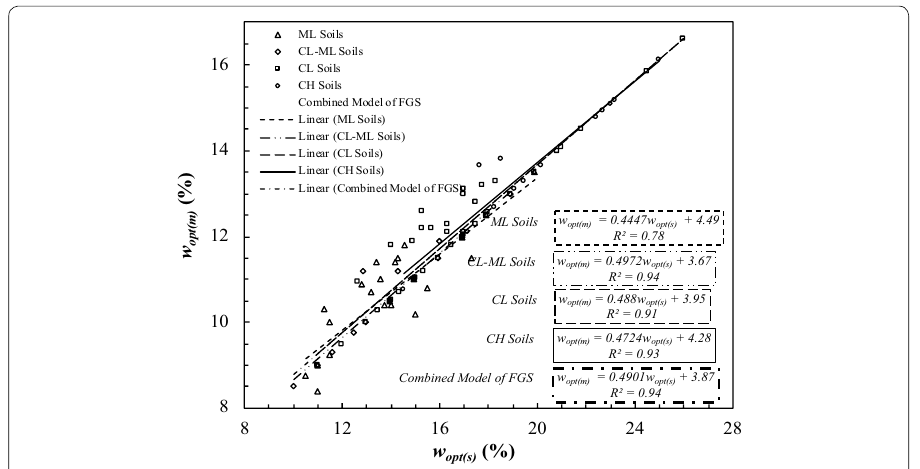
Fig. 9 Correlations of modified optimum water content ( w opt(m) ) with standard optimum water content (